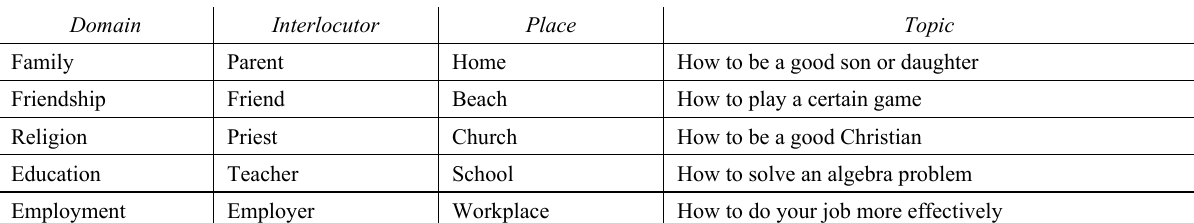
The Scheme of Relationships in Fishman’s (1972) Domain